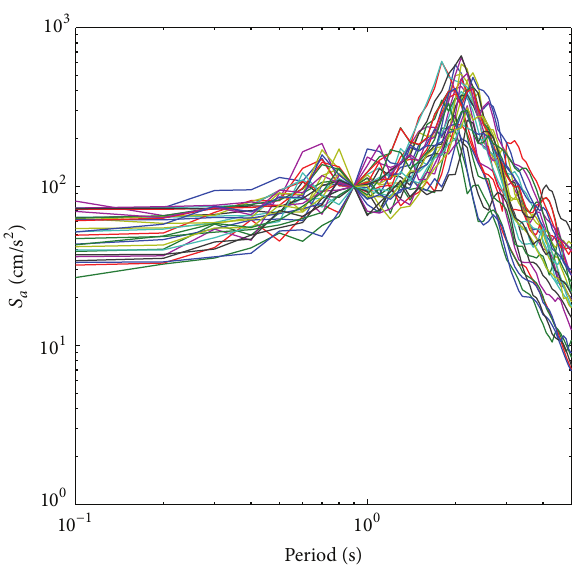
Figure 4: Elastic response spectra for the records scaled at the same spectral acceleration 𝑆 𝑎 (𝑇 1 ) = 100 cm/s 2 for period equal to 0.9s and 3% of critical